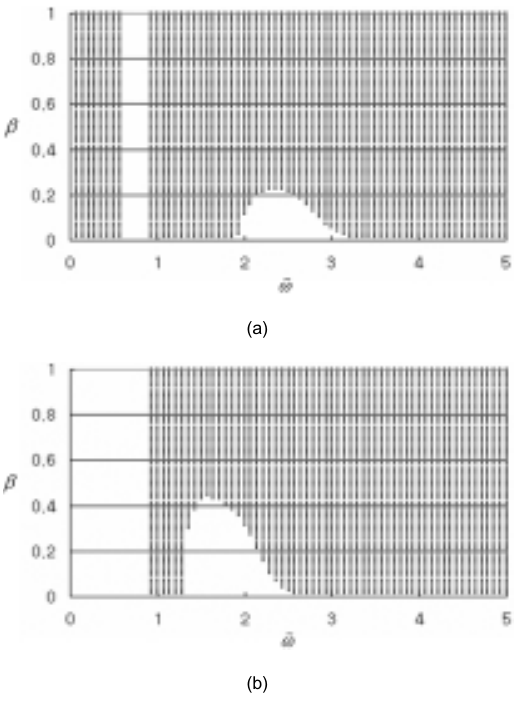
Fig. 5. Comparison of stability for the variation of ˜ ω and β . (a) Pendulum Automatic Dynamic Balancer. (b) Ball Automatic Dynamic